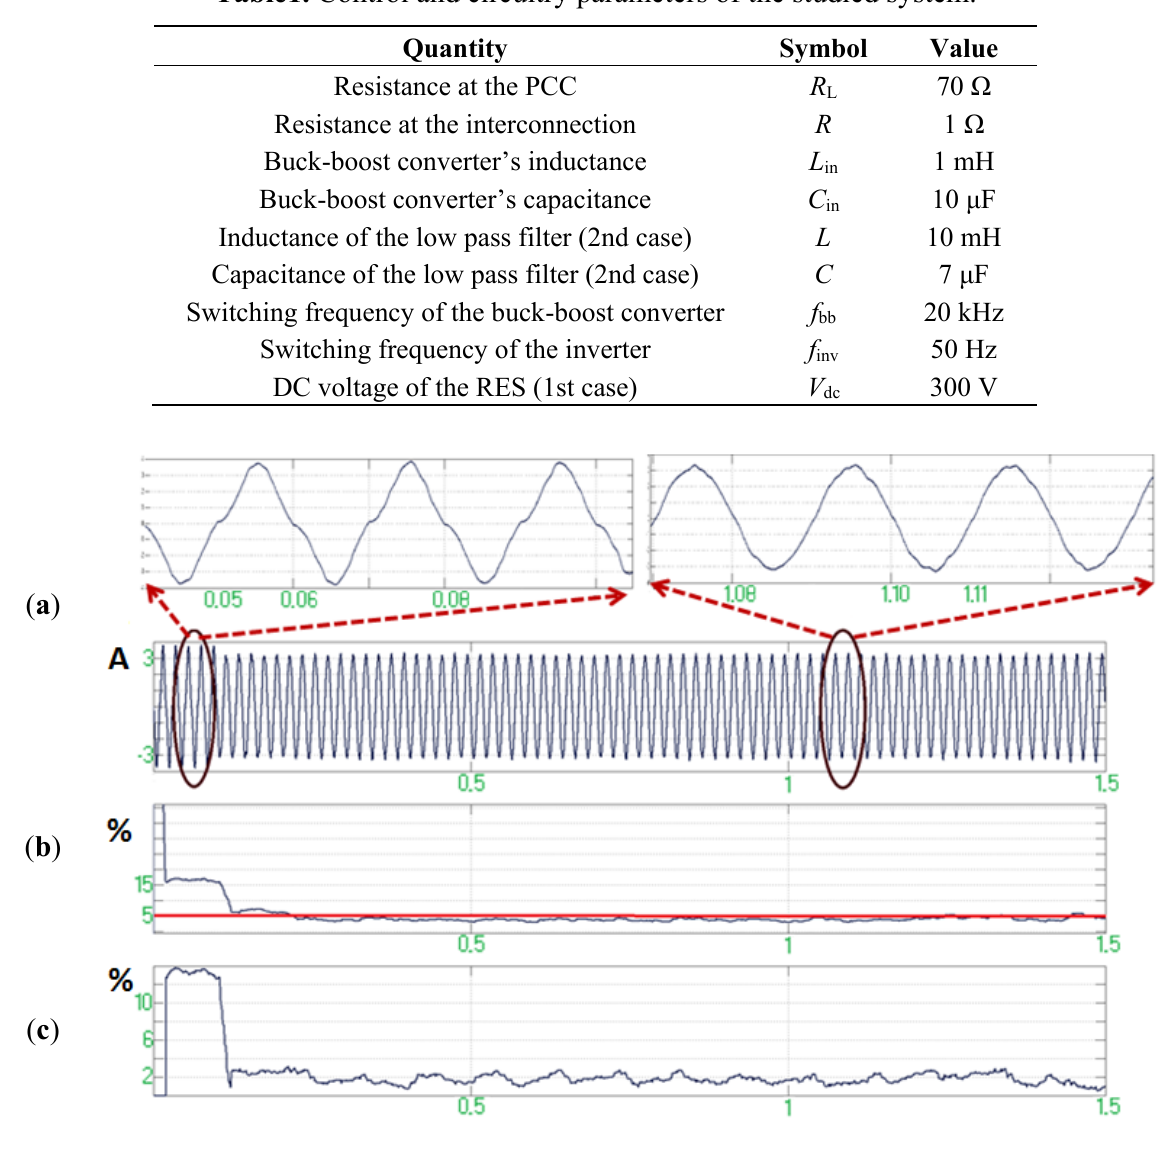
Figure 5. ( a ) Grid’s current 𝐼 component in the first